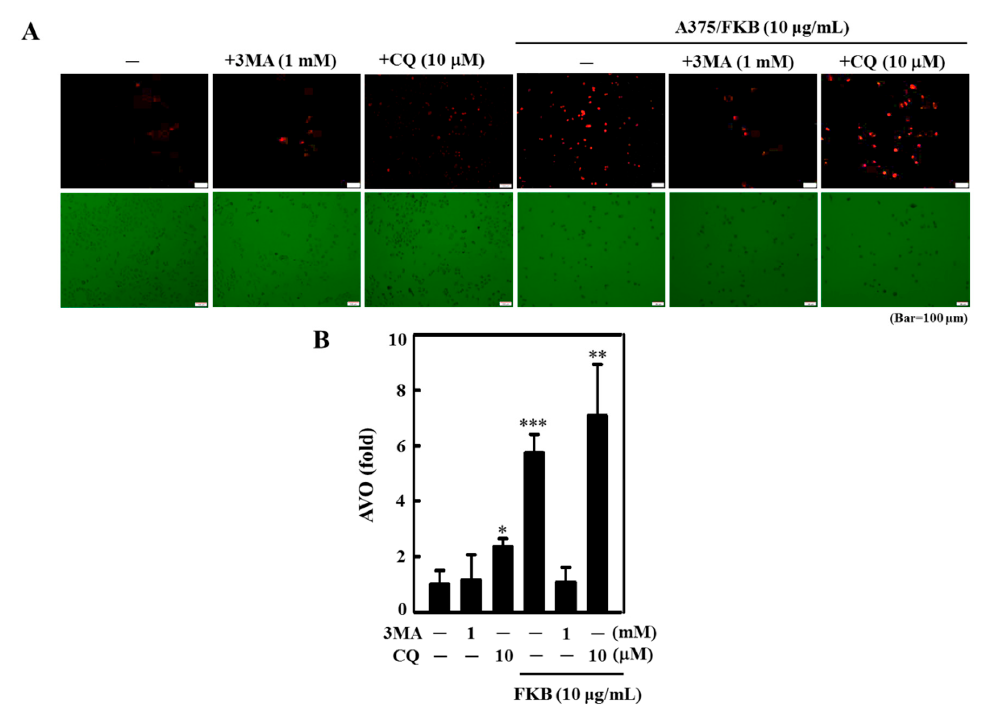
Figure 7. Effect of autophagy inhibitors on the FKB-mediated AVOs formation in A375 cells. ( A , B ) A375 cells were pretreated with 3-methyladenine (3-MA) (1 mM) or chloroquine (CQ) (10 µM) for 1 h followed by FKB treatment (10 µ g / mL) for 24 h and then stained with acridine orange (AO) to observe the AVOs formed in the cells. These AVOs were visualized using the fluorescence microscope under a red filter (100 × magnification). The fluorescence intensity was proportionate to the number of AVOs formed in the cells. Histogram representing the fold change of AVOs formation in di ff erent experimental conditions, in which the control value was arbitrarily assigned as one. Each value was expressed as mean ± standard deviation (SD) of three experiments. Statistical significance was assigned as * p < 0.05, ** p < 0.01, and *** p < 0.001 as compared to the untreated control